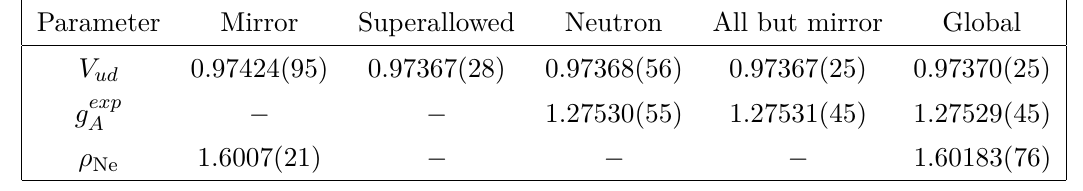
, and the mixing A and V in the neutron column are ud A / dof = 0 . 8 . The same holds for min = 0 . 9740(28) [66, ud